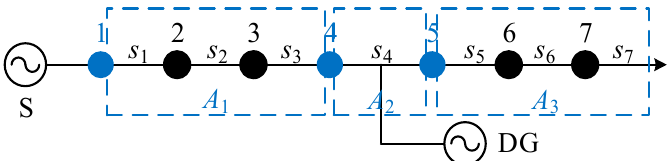
Figure 4. Distribution network with “T” connected to DG.